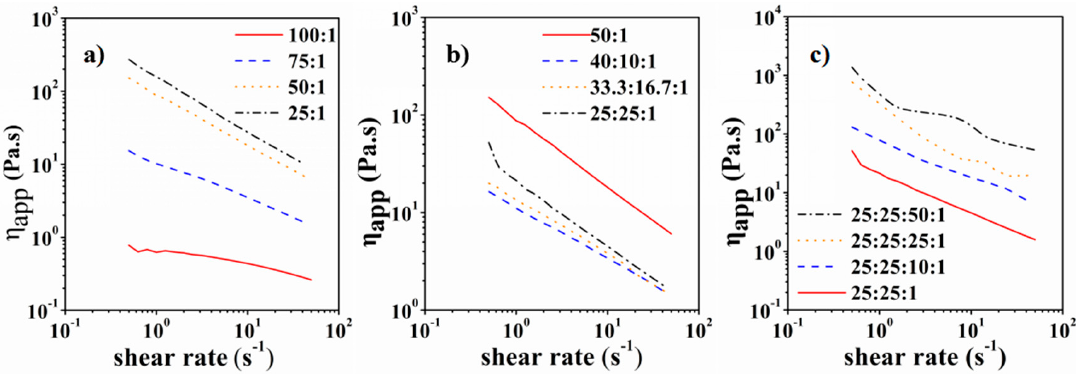
Figure 3. Rheological properties of LFP inks: ( a ) carboxy methyl cellulose (CMC) water solution; ( b ) CMC-water-1,4 dioxane solution; ( c ) LFP-CMC-water-1,4 dioxane ink.